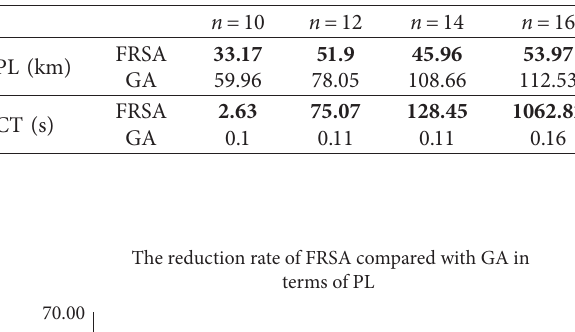
Figure 5: The diagrams of the node connection in different network cases. (a) n � 10, (b) n � 12, (c) n � 14, and (d) n � 16. Table 1: The optimization results of FRSA and GA in different nodes size scenarios.